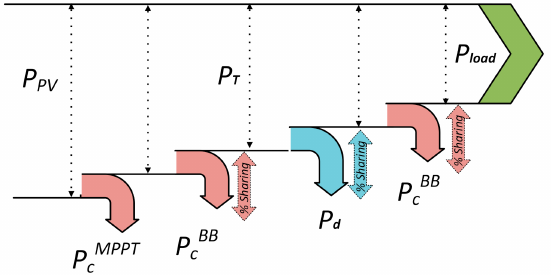
Figure 8. Power flow diagram for distributed generation and distributed storage